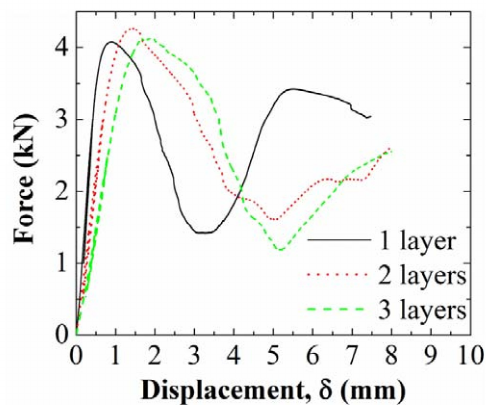
Figure 6. Force-displacement curves of Kagome structure with a di ff erent number of